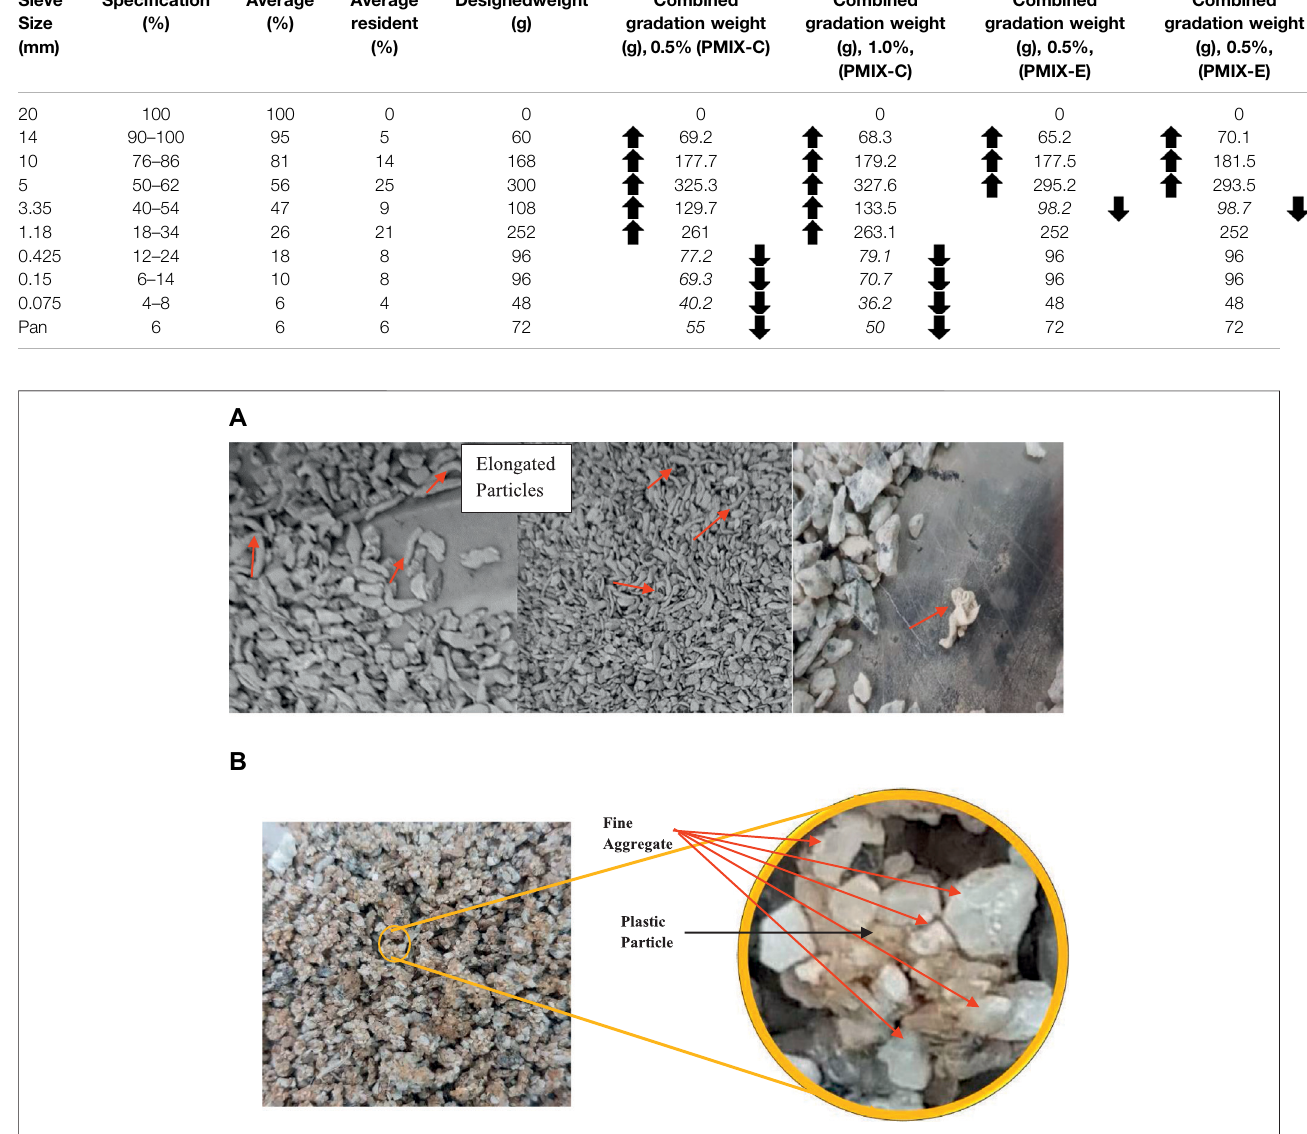
FIGURE 3 | Plastic waste particle transformation in fi nal gradation. (A) Plastic waste particles transformation into elongated shape retained on sieves size (5 – 3.35 mm); (B) cluster of plastic waste particles and fi ne aggregate retained on sieves size (1.18 mm).